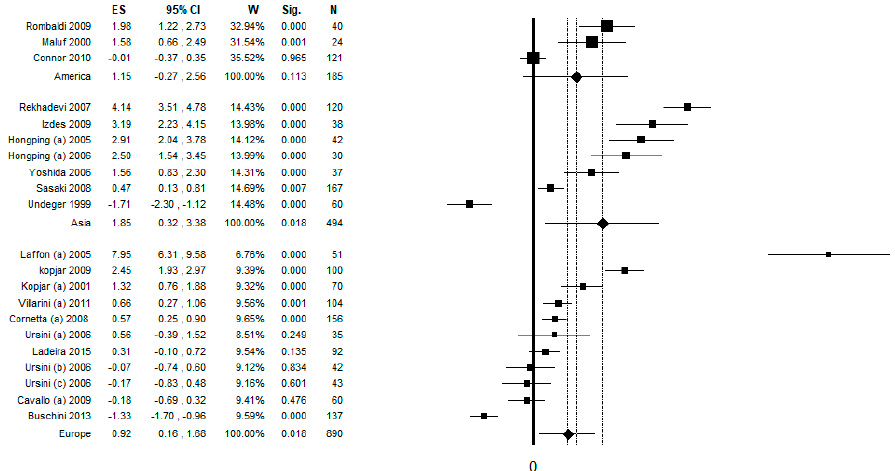
Figure 8. Forest plot of sub-group analysis by continent, assessing the comet assay on lymphocytes cells among professionals occupationally exposed to antineoplastic drugs (ANDs).